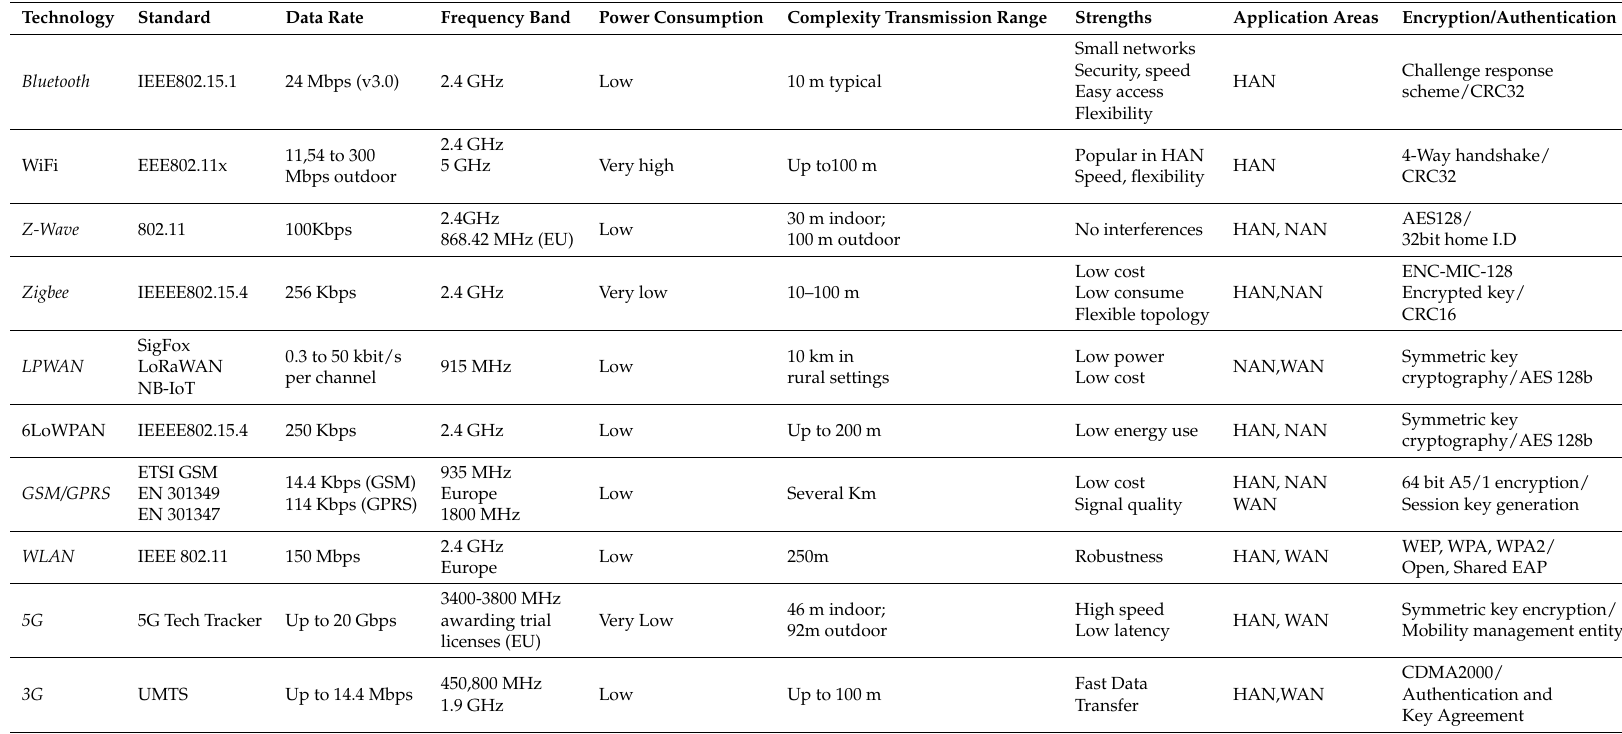
Table 5. Wireless